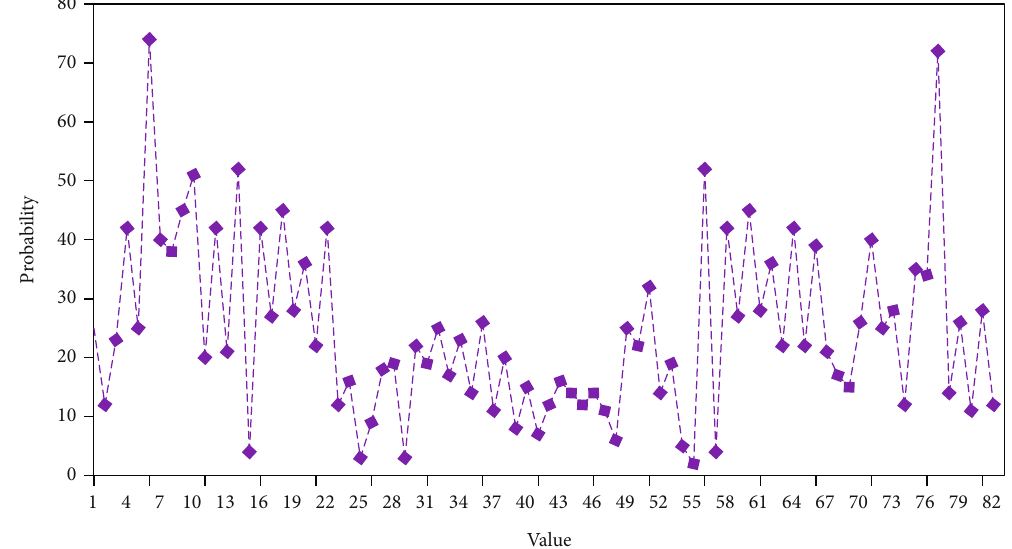
Figure 3: Probability distribution of the reliable class of adjacent point elements i and r .